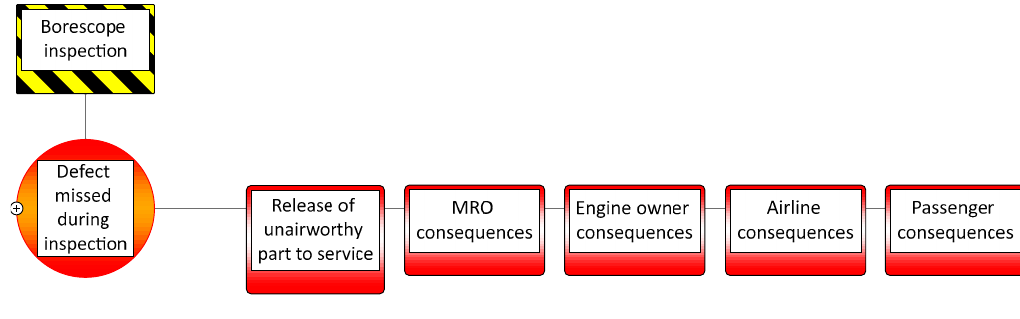
Figure 5. Cascading consequences with different stakeholders.